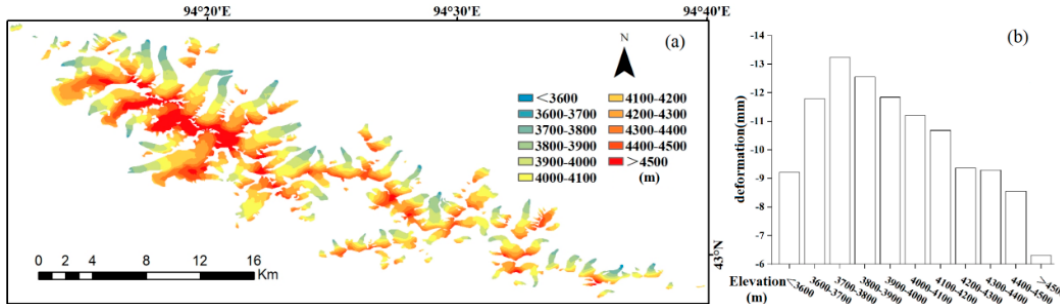
Figure 10. ( a ) Glacier elevation (m) in the study area. ( b ) Statistics of measured glacier deformation at different elevations.